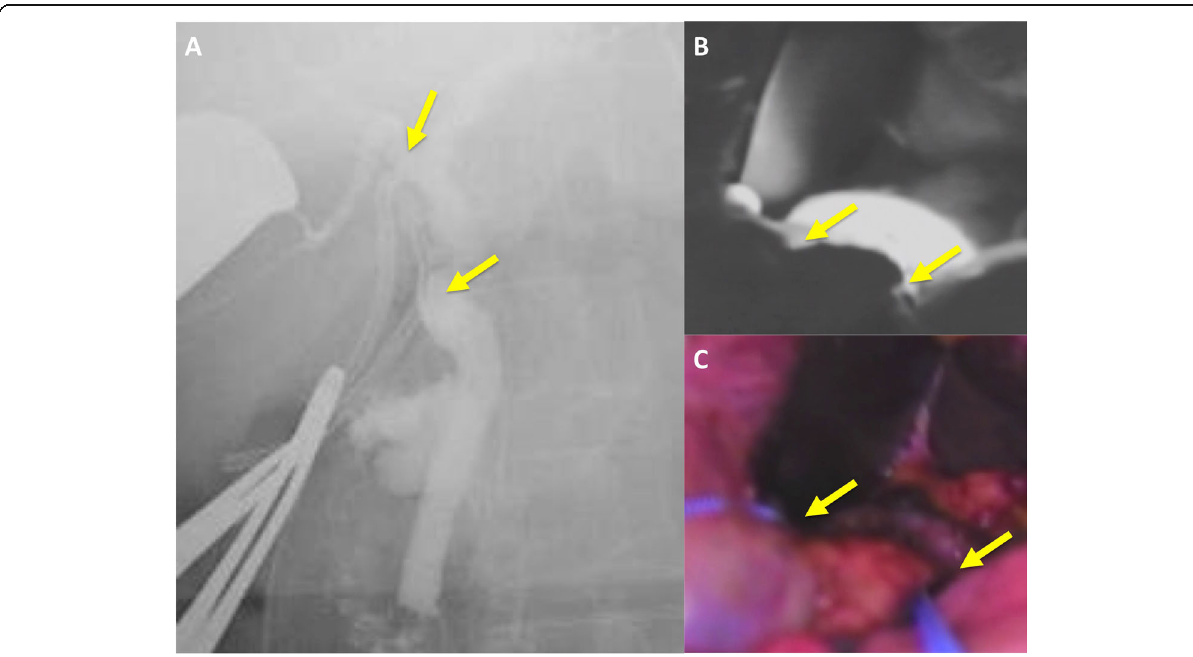
Fig. 7 Intraoperative cholangiography. a Normal cholangiogram via iodine contrast agent. b , c Biliary images via a near-infrared ray vision system (Photo Dynamic Eye ® : PDE). An intraoperative cholangiogram through the primary cystic duct showed the correct ductal anatomy. A pair of cystic ducts (indicated by arrows) were